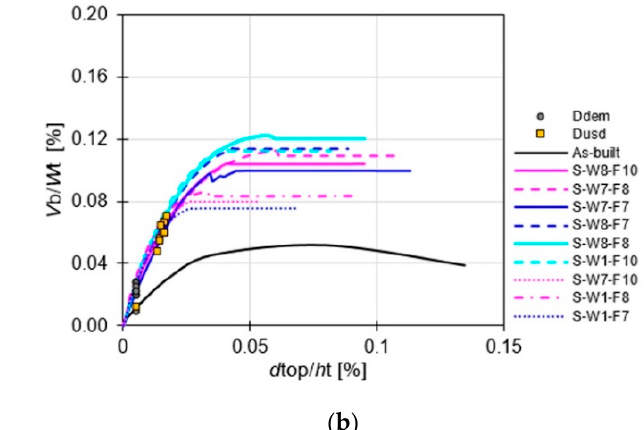
Figure 18. Combined energy and seismic benefit and cost of each integrated RP3 retrofitting config- uration considered. When combining the RP and RP 3 configurations, it was obtained that the seismic im- provement leads to the highest differences in the results. This is due to the similar energy performance enhancement achieved for all the orientations and hypotheses considered. Nevertheless, the solutions with aluminium window frames and EPS insulation attained higher B/C ratios. In the case of the B S , there is a considerable difference in the benefit/cost ratio of solutions that add lower and intermediate values of retrofitting material than